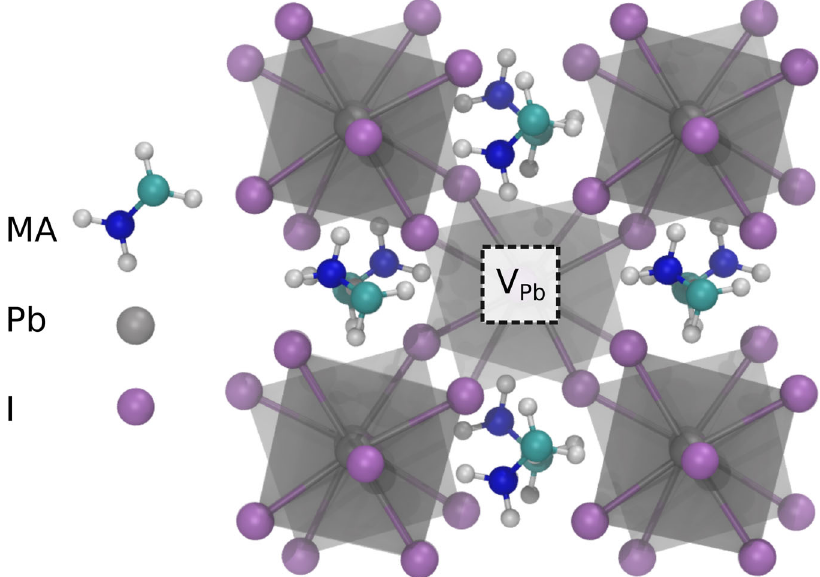
Fig. 1 MAPbI 3 crystal structure. Illustrating B-site polyhedra (gray), and showing a Pb